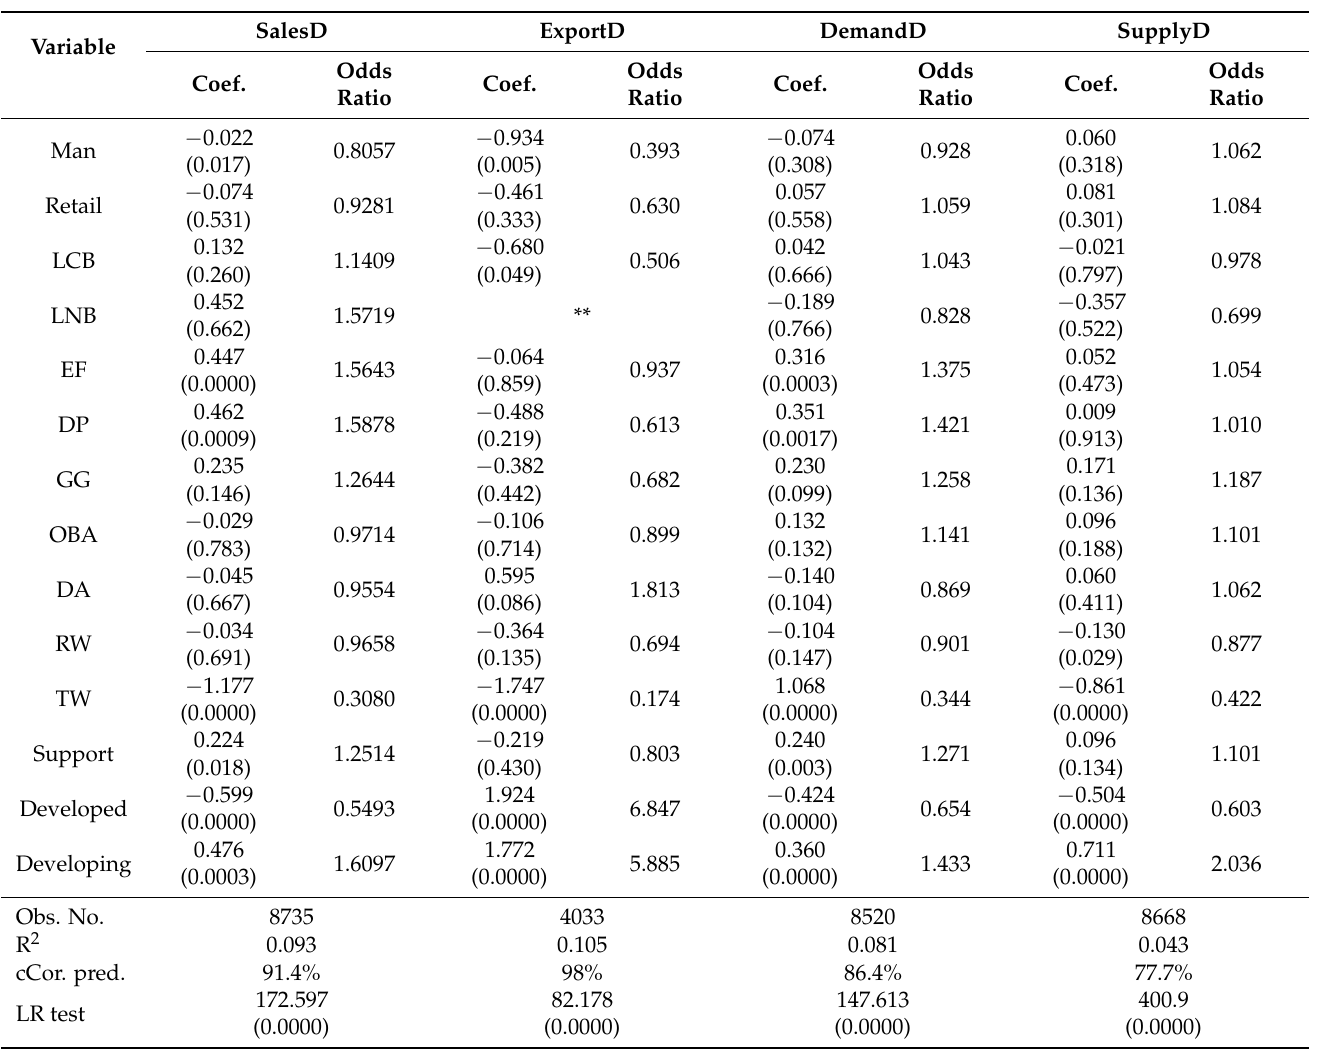
Table 4. Logit binary model’s estimation results